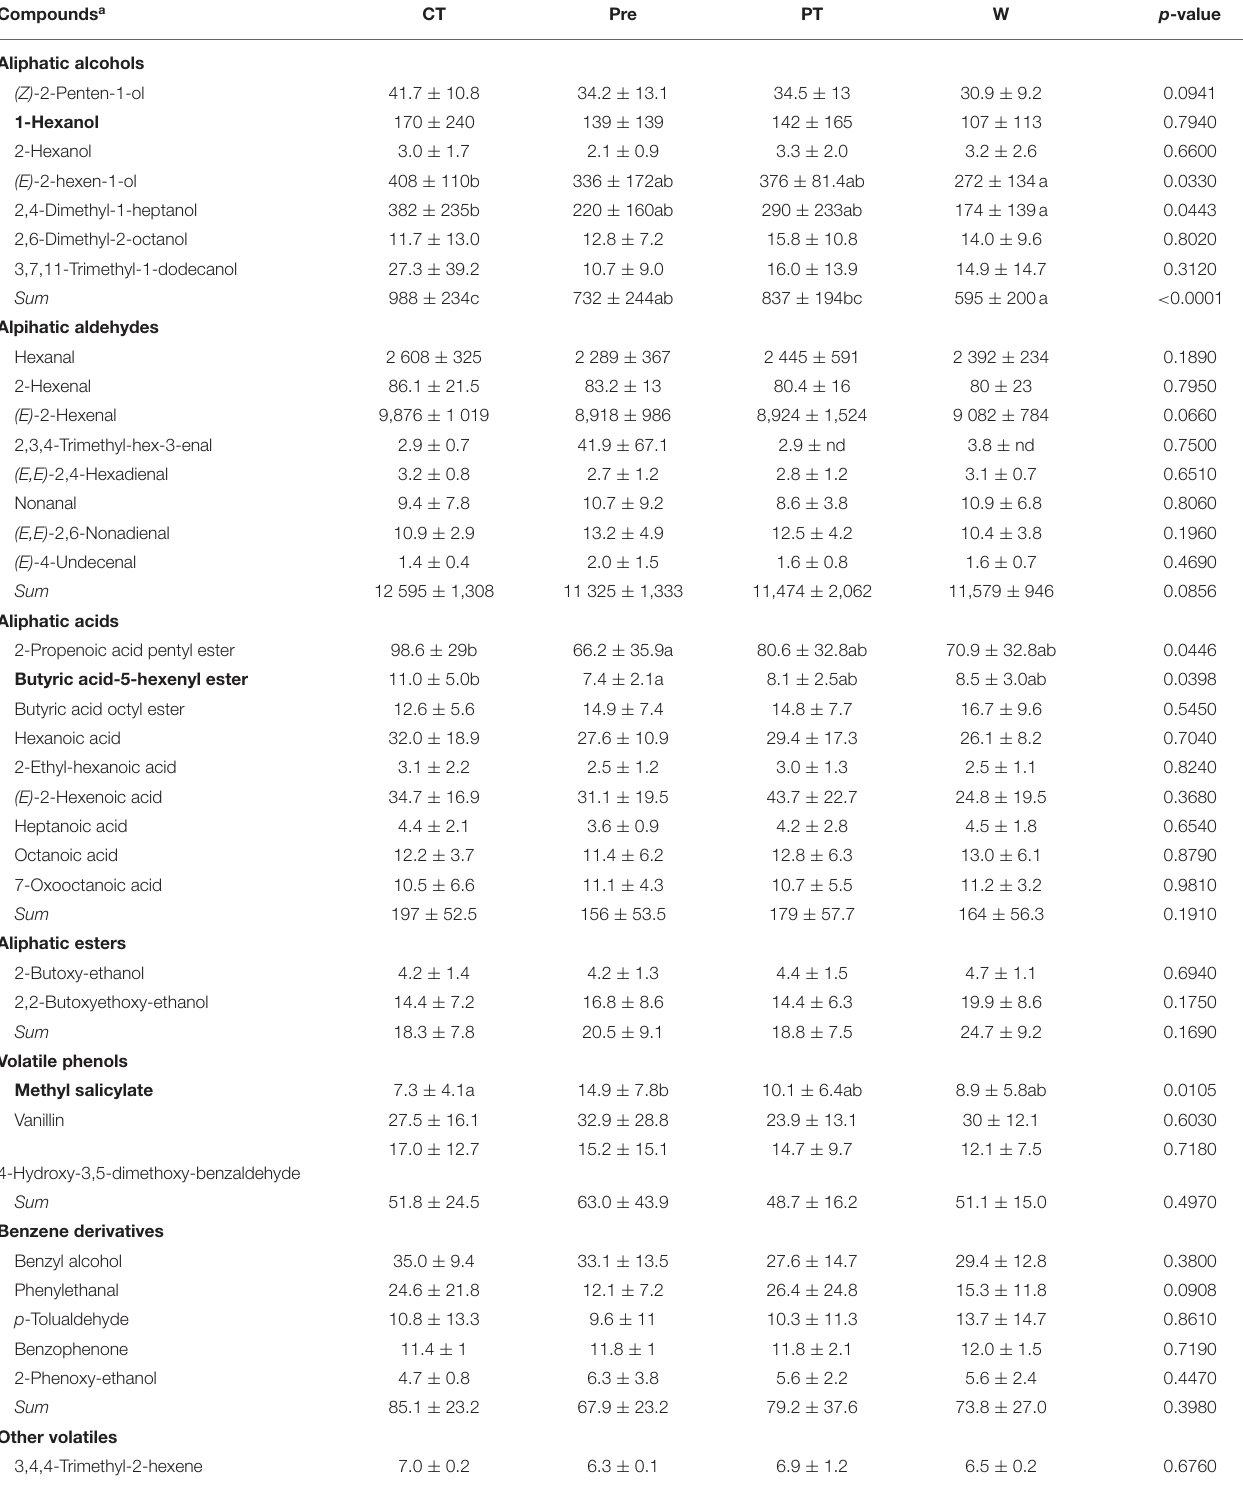
TABLE 3 | Impact of the temperature treatments (Control; Pre, pre-veraison; Post, post-veraison; Whole, whole season) on the profile of free volatile compounds (ng · g − 1 FW) of berries from Vitis sp. cv. L’Acadie blanc in 2020.